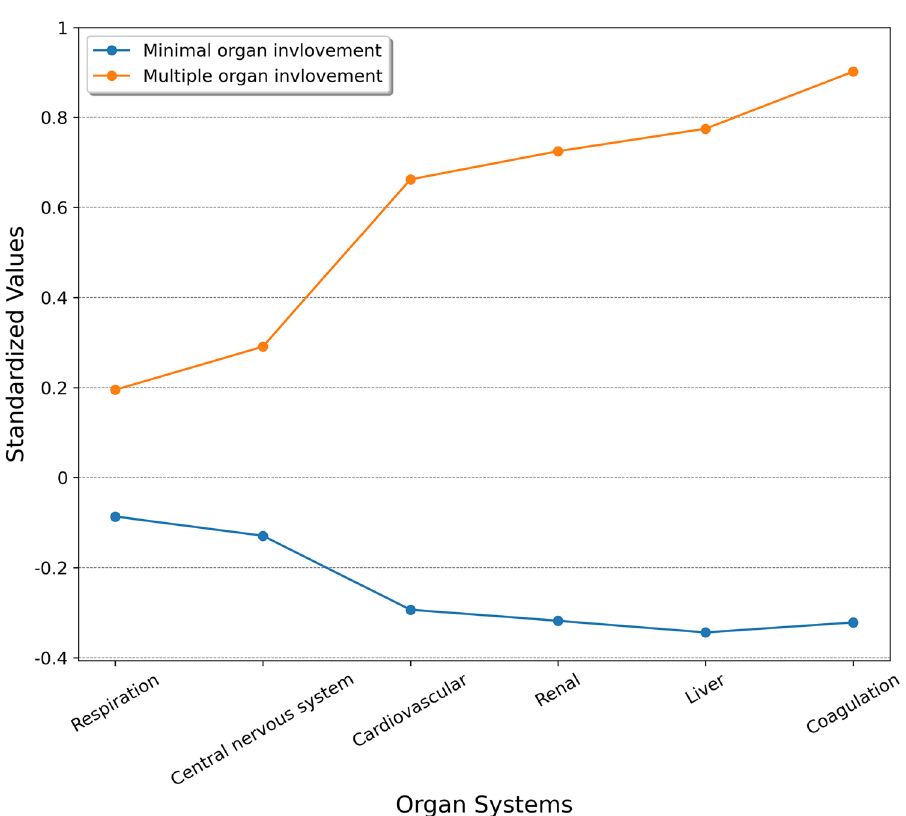
Figure 1. Differences in standardized values of each SOFA subscore by subtype. The y-axis represents standardized values, in which all means were scaled to 0 and standard deviations to 1. SOFA Sequential Organ Failure